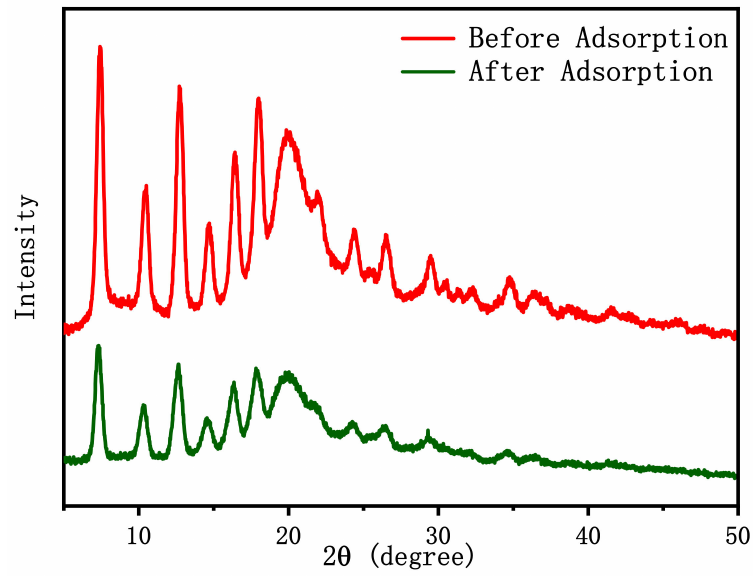
Figure 15. XRD of EDTA–CS@ZIF-8 composites before and after adsorption of Eu(III).